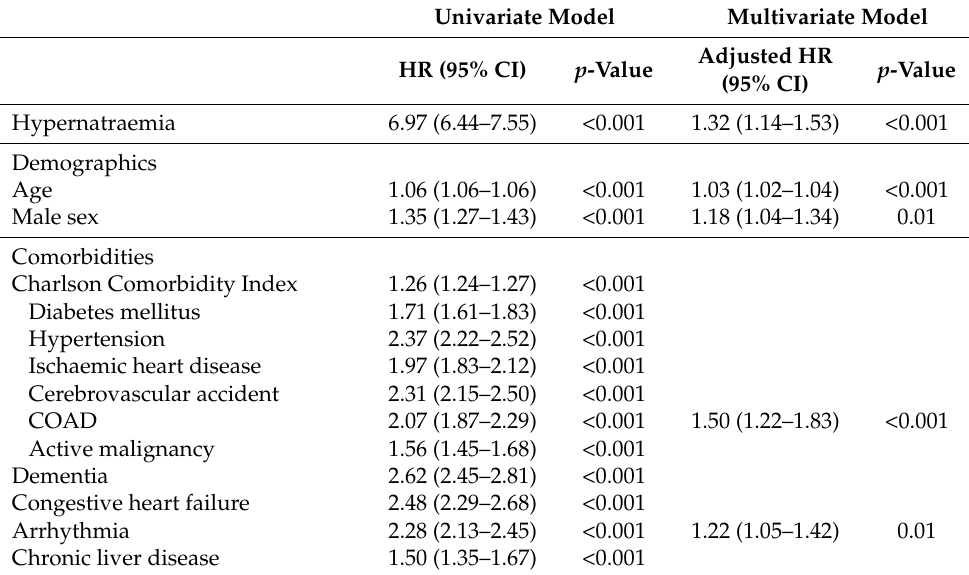
Table 9. Risk factors for 30-day mortality in patients with